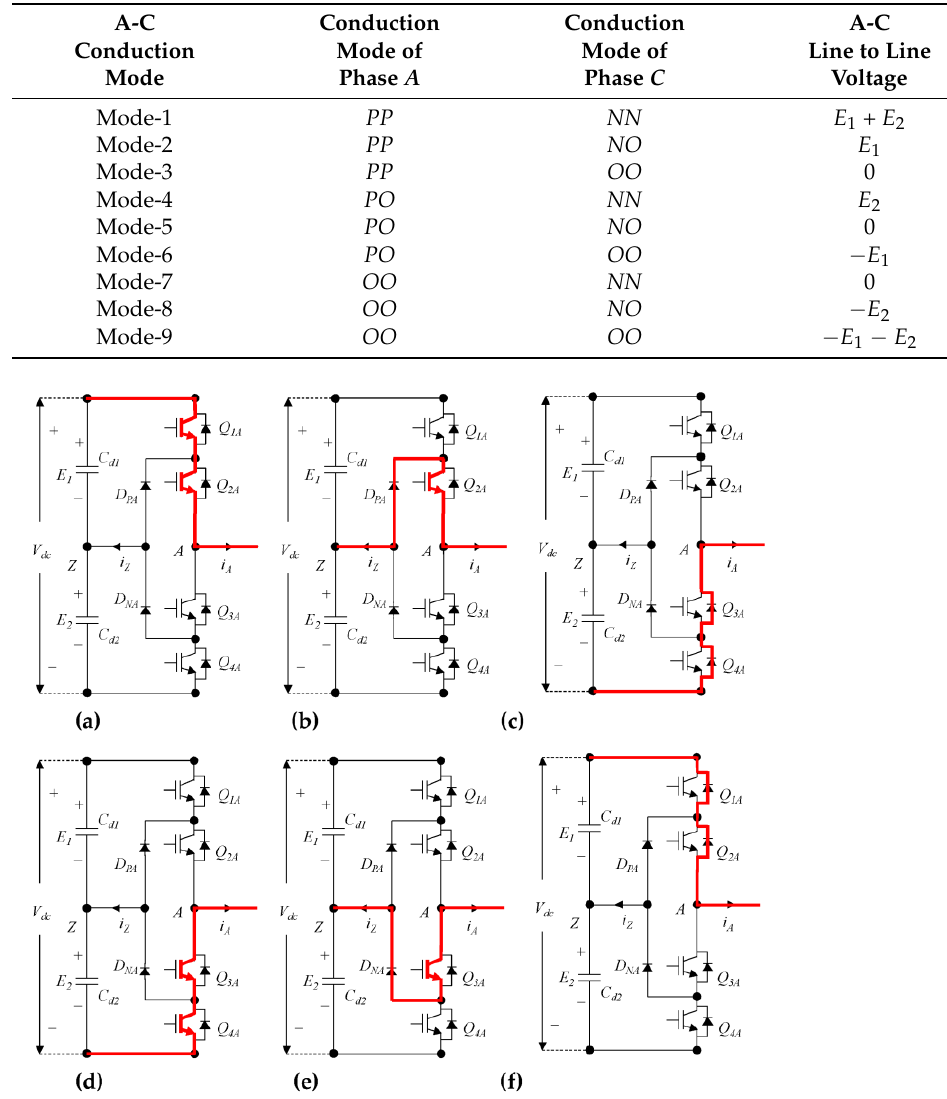
Figure 7. Current path of each conduction mode for phase A : ( a ) PP mode; ( b ) PO mode; ( c ) OO mode ( i A > 0); ( d ) NN mode; ( e ) NO mode; ( f ) OO mode ( i A < 0).